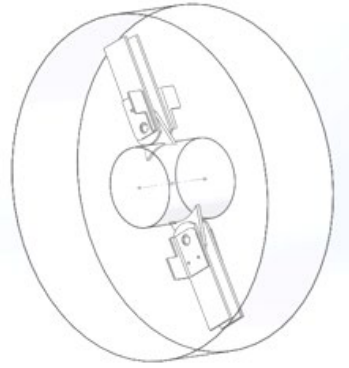
Agriculture 2022 , 12 , 1291 Figure 14. Rotation model of wind blade. Figure 14. Rotation model of wind blade.